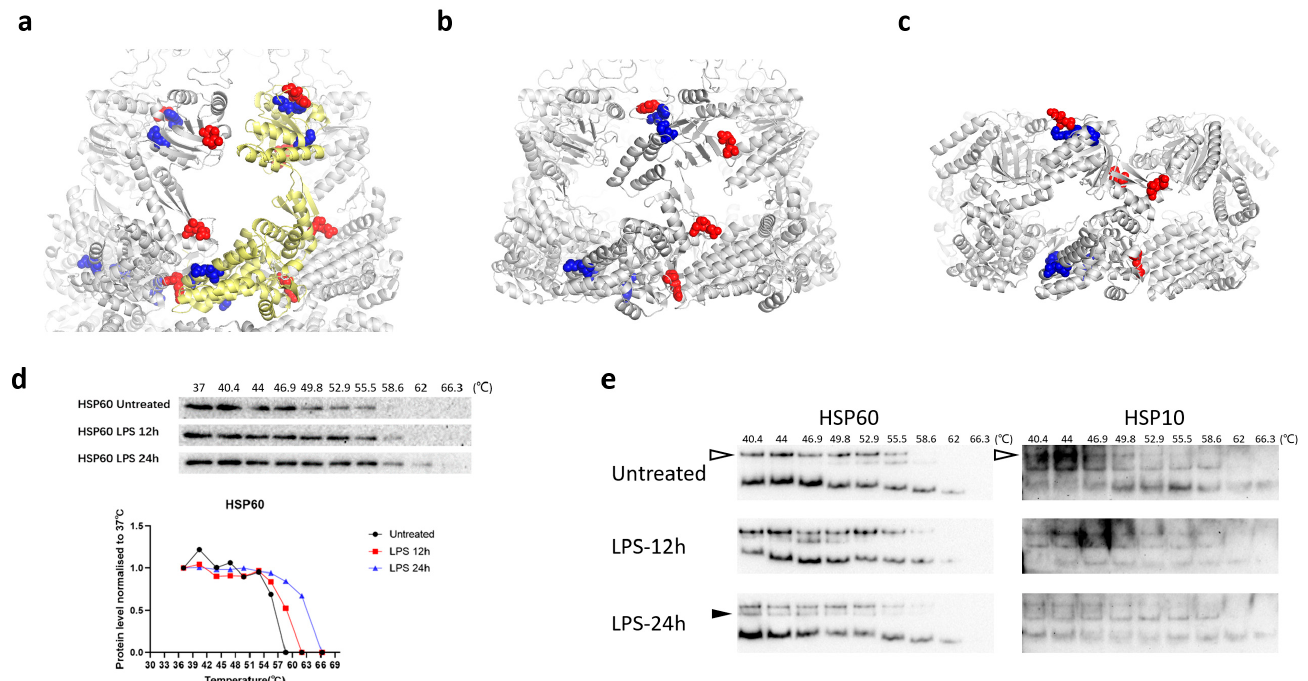
Figure 5. Structural changes in HSP60 during macrophage activation. ( a ) HSP60–HSP10 football-type complex. (PDB ID: 4PJ1); ( b ) HSP60–HSP10 bullet-type complex. (PDB ID: 6MRD); ( c ) HSP60 single-ring complex. (PDB ID: 7AZP) (Blue: Proteinase K cleavage site significantly decreased in LiP-MS analysis. Red: Proteinase K cleavage sites significantly increased in LiP-MS analysis. Pale yellow: HSP60 protein that has a different conformation to the other HSP60 proteins in this complex.); ( d ) CETSA analysis of HSP60; ( e ) native CETSA analysis of HSP60 and HSP10. (Hollow triangles indicate the complex formed by HSP60 and HSP10; the filled triangles indicate the complex formed by HSP60 without